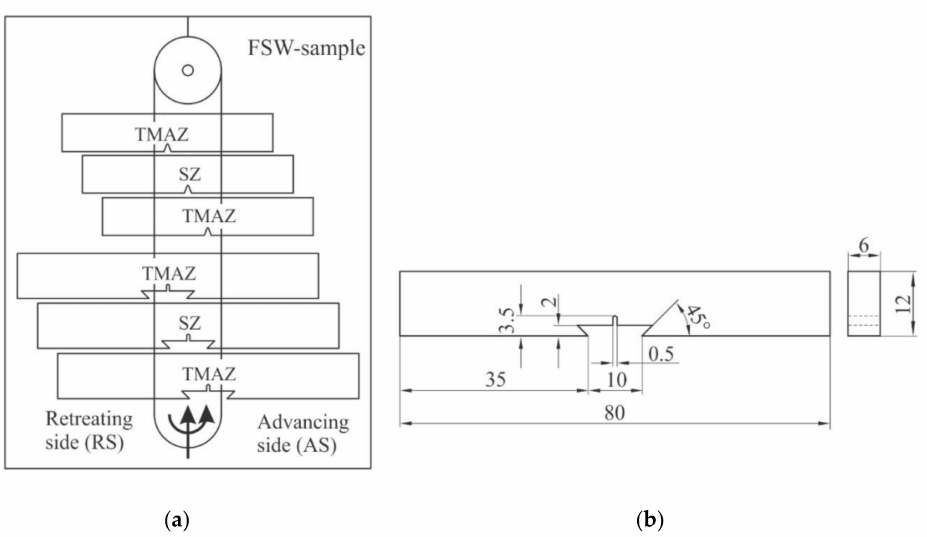
Figure 4. Subtraction of the plate specimen ( a ); specimen for the fracture toughness testing ( b ). (TMAZ—notch position 4 mm from center of weld on advancing side (AS) and retreating side (RS); SZ—notch position in center of